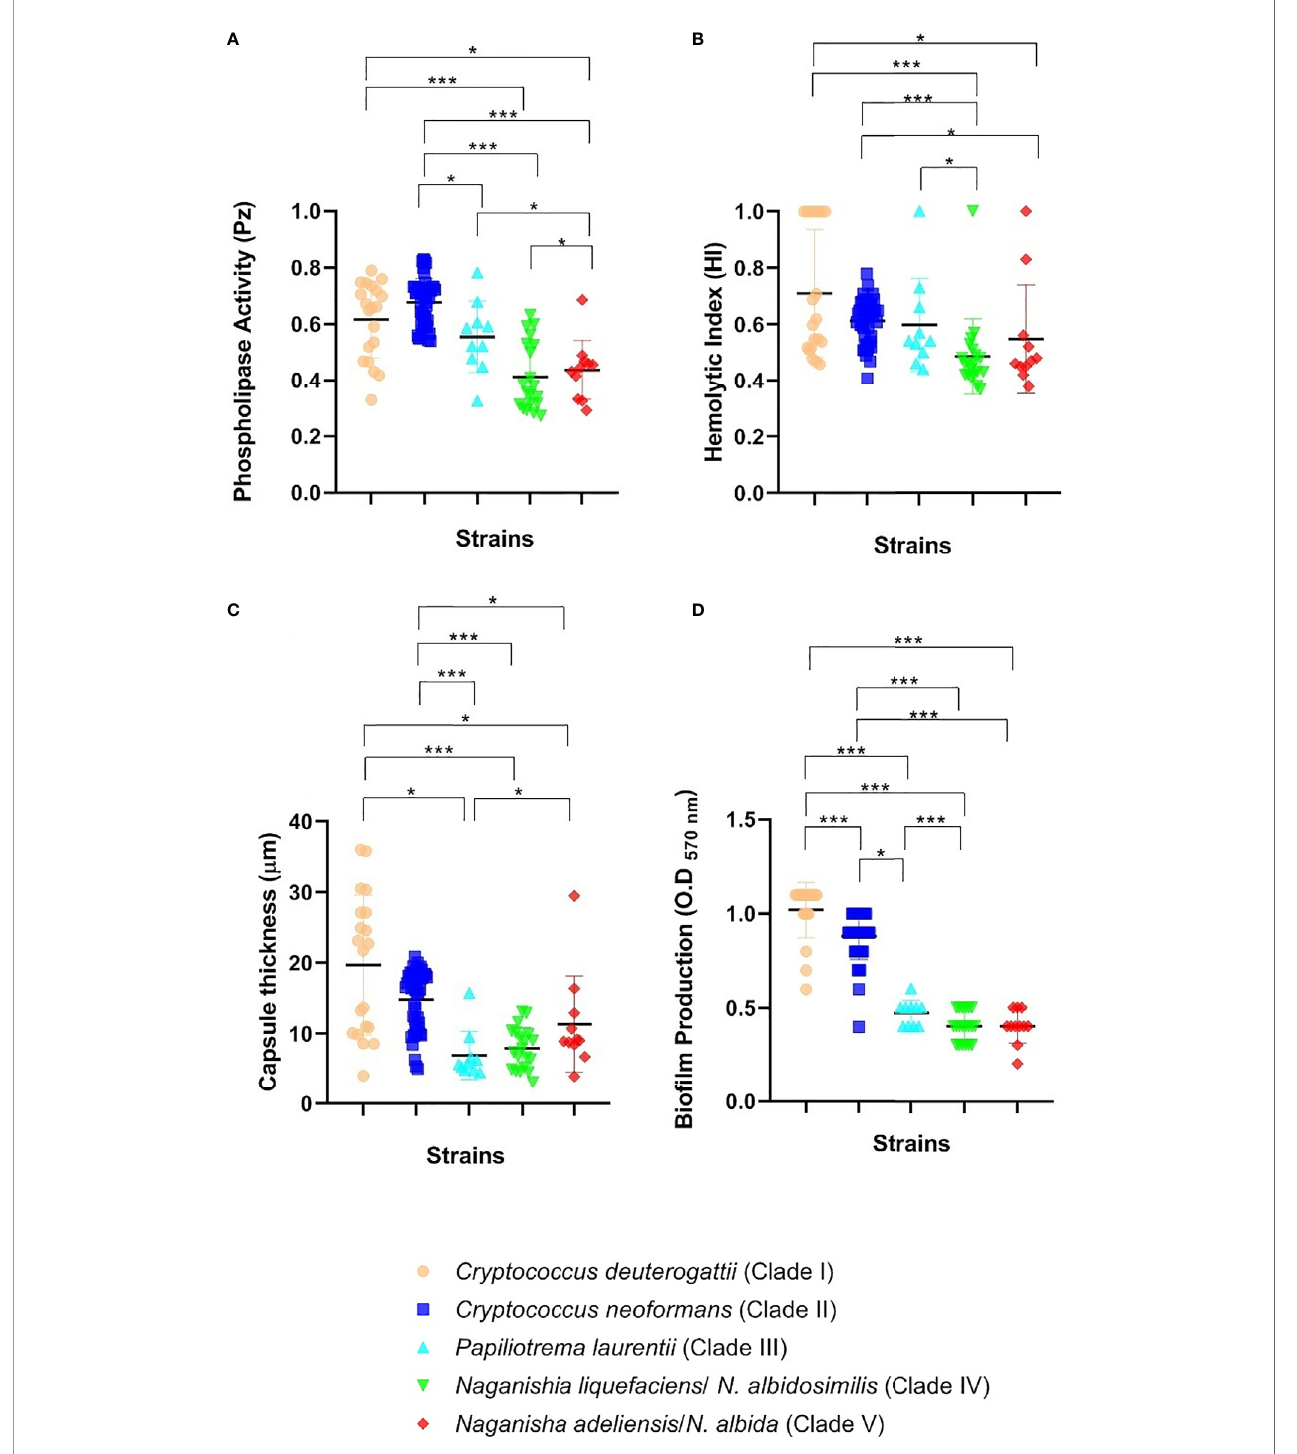
FIGURE 3 | Virulence factors attributes of clinical and environmental strains of Cryptococcus spp. and related genera. (A) Phosphoplipase zone determined after incubating cells on egg yolk agar medium at 30°C, for 72 h. (B) Hemolytic index after incubation on SDA supplemented with sheep ’ s blood and glucose at 37°C for 48 h, 5% CO 2 . (C) Capsule thickness determined after cells incubation in 10% fetal bovine serum in PBS, incubated for 24 h at 37°C in an atmosphere of 5% CO 2 and (D) Bio fi lm formation induced after cells incubation in 96-wells microtiter plates containing BHI medium at 37°C, for 48 h. Each bar represents mean ± standard deviation of the triplicate obtained for each isolate. *P < 0.05; ***P <